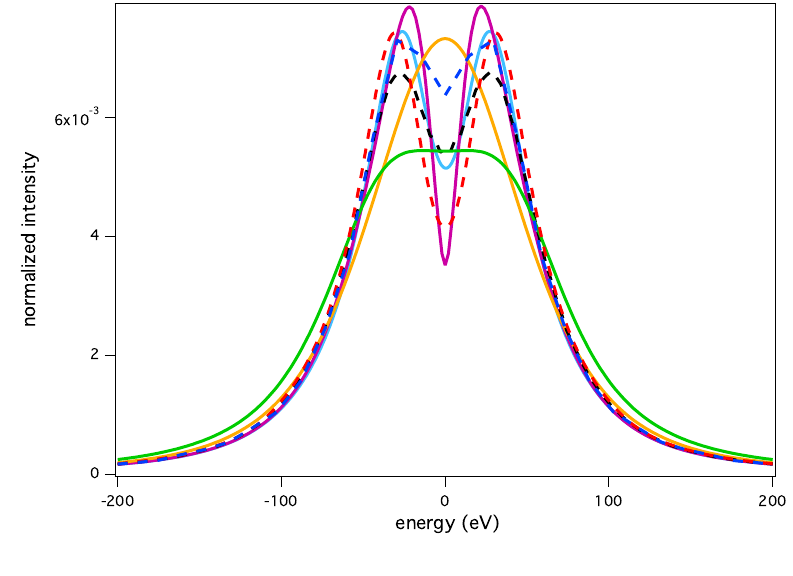
= 10 17 cm (cid:0) 3 and T = 10 eV: SimU (black dash); Figure 5. Lyman- (cid:12) line for n e ER-simulation (red dash); Xenomorph (blue dot-dash); PPP (solid cyan); QC-FFM (solid orange); QuantST. MMM (solid purple); UTPP (solid